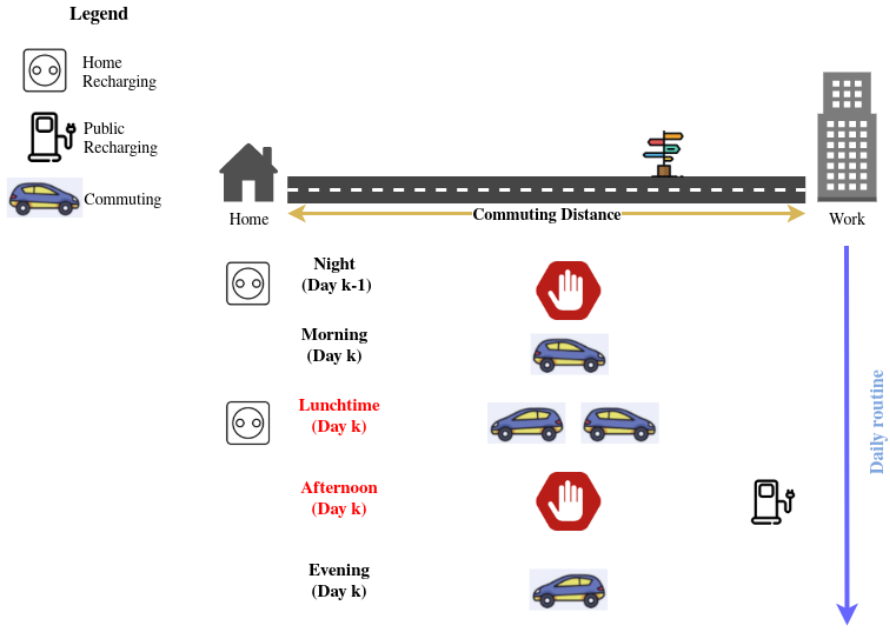
Figure 6. Customer’s daily